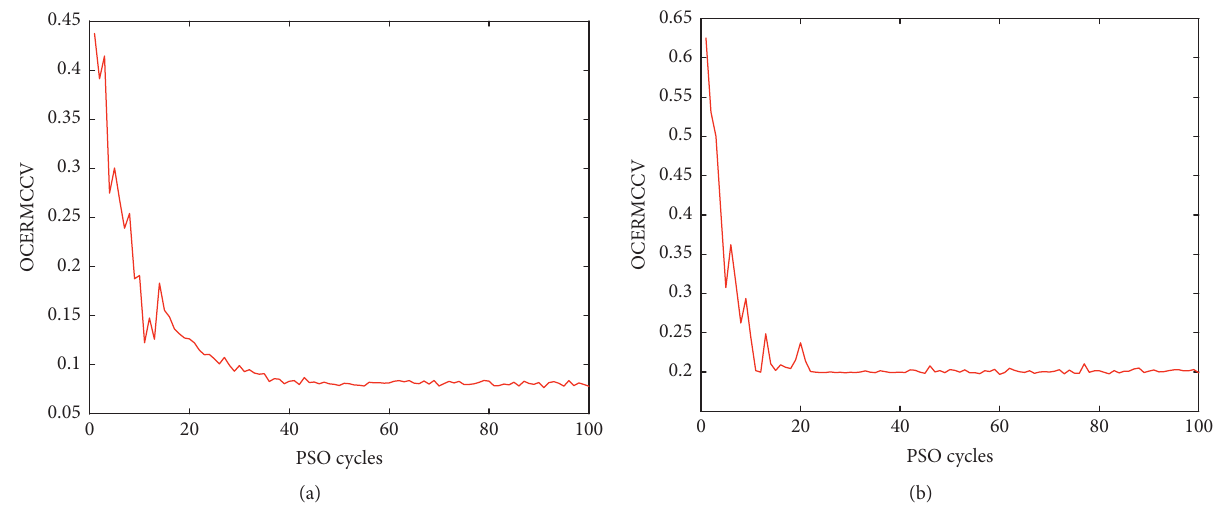
Figure 2: Trends of MCCV classification errors for 8-variable OVO-PLSDA and 10-variable OVR-PLSDA in 100 PSO